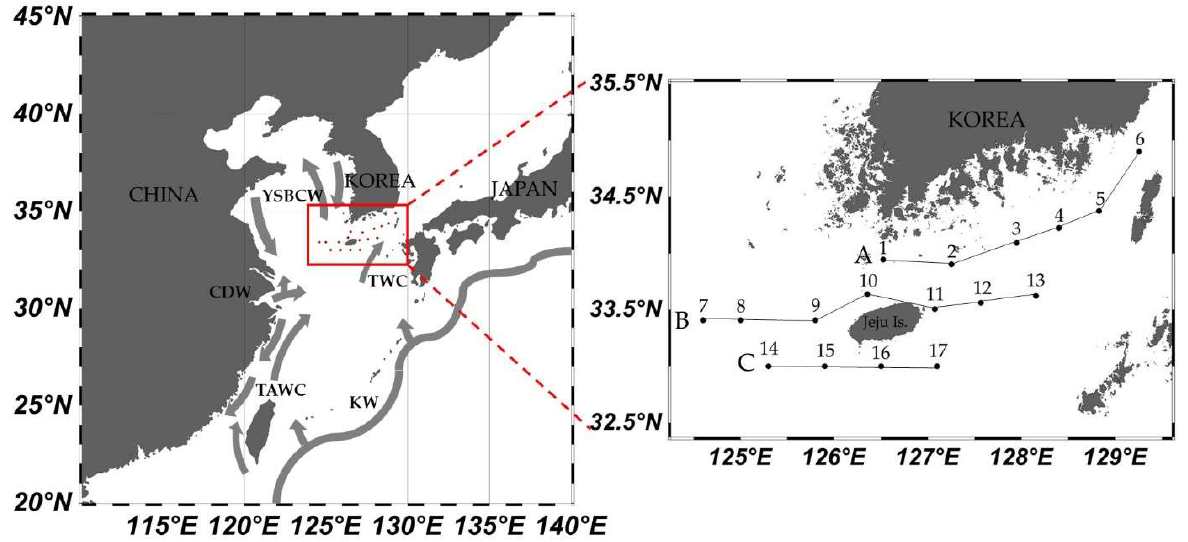
Figure 1. Map of the study sites. Abbreviations: CDW: Changjiang diluted water; Jeju Is.: Jeju Island; TWC: Tsushima Warm Current; TAWC: Taiwan Warm Current water; YSBCW: Yellow Sea bottom cold water; and KW: Kuroshio water. Table 1. Geographic coordinates of the study sites in the Korea South Sea.